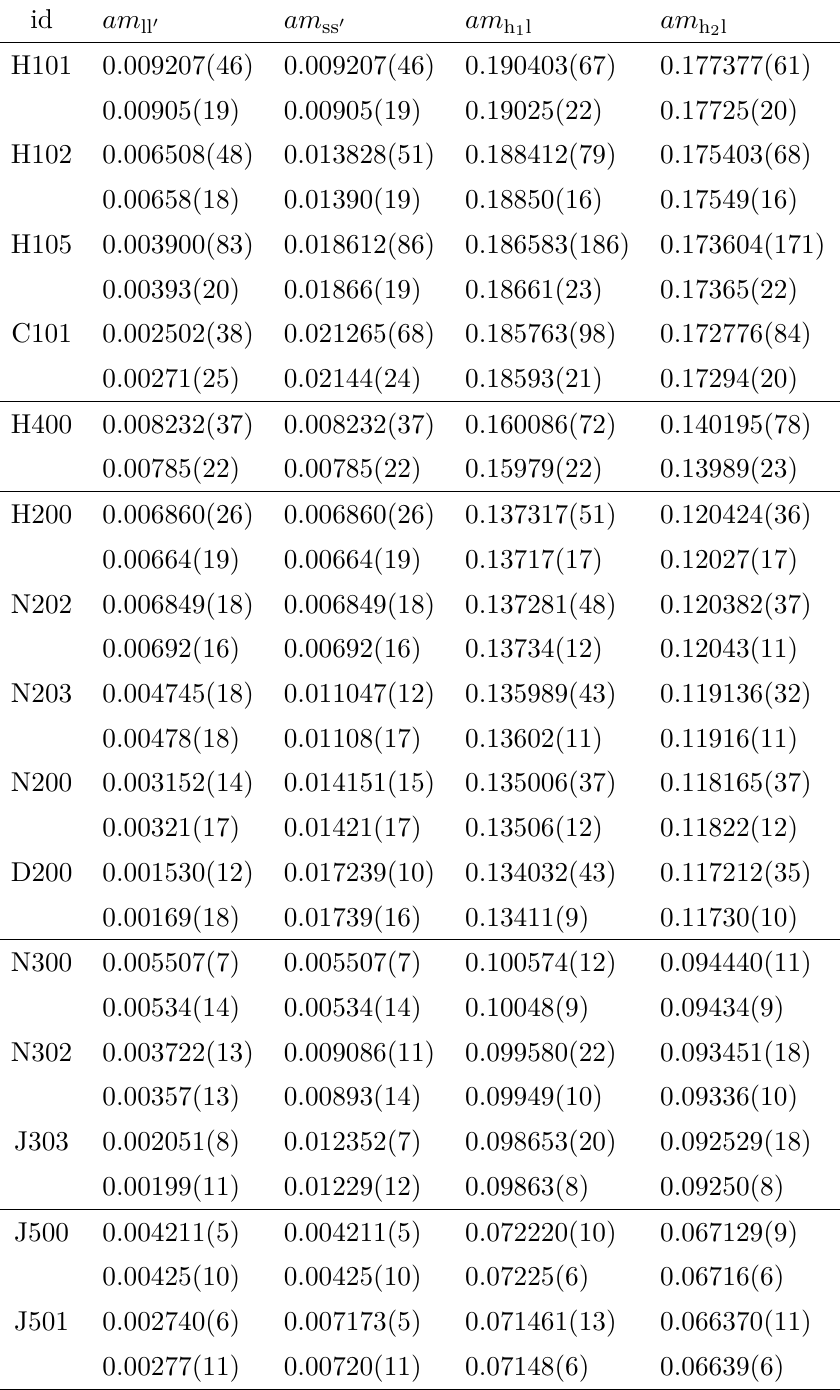
Table 6 . Overview of the results for light-light, strange-strange and heavy-light PCAC quark masses from standard lattice derivatives, where the heavy quark hopping parameter choices in the charm region refer to table 2. As before, for every ensemble we list the numbers before the shift in the rows with labels and the corresponding ones after the shift to φ phys Analogous results from improved lattice derivatives are collected in table